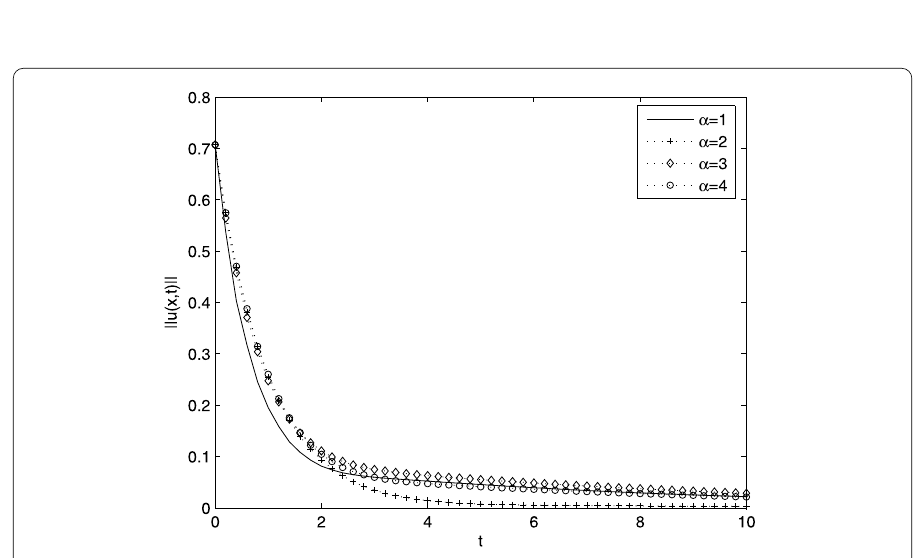
Figure 4 A 3-d landscape of the dynamics of the MGKdVB equation when using the first nonlinear non-adaptive control law; v = 0.01, μ = 0.001, γ 1 = 1, γ 2 = 0.0005 and u 0 ( x ) = sin(2 π x ); ( a ) α = 1; ( b ) α = 2; ( c ) α = 3; ( d ) α = 4